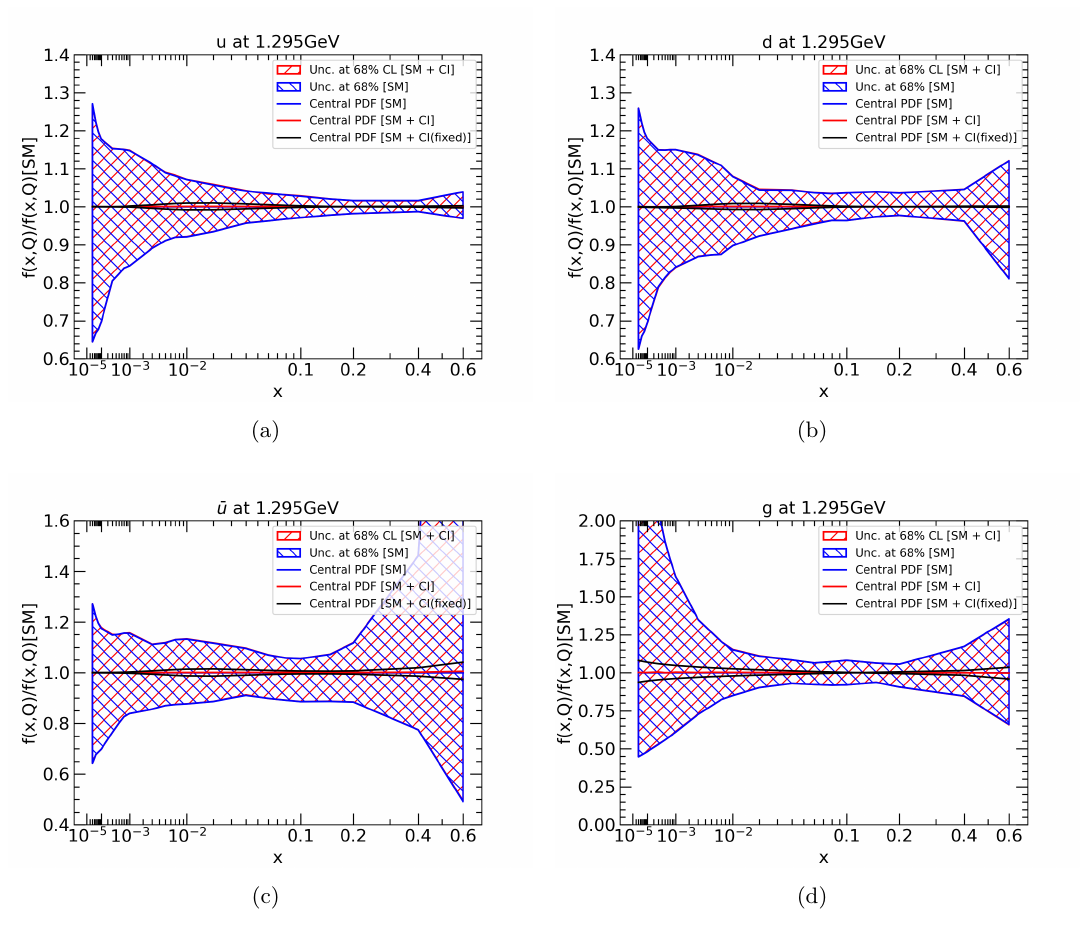
Figure 23 . The parton distribution functions at Q = 1 . 295 GeV for u , d , ¯ u and g . The blue and the red solid lines represent the central values determined by fitting without and with the new physics contributions respectively, and the blue and the red hatched areas represent the respective uncertainties at 68% CL. The black solid lines represent the PDFs when ˜ c/ Λ 2 is fixed at -8.60 or 9.72 TeV − 2